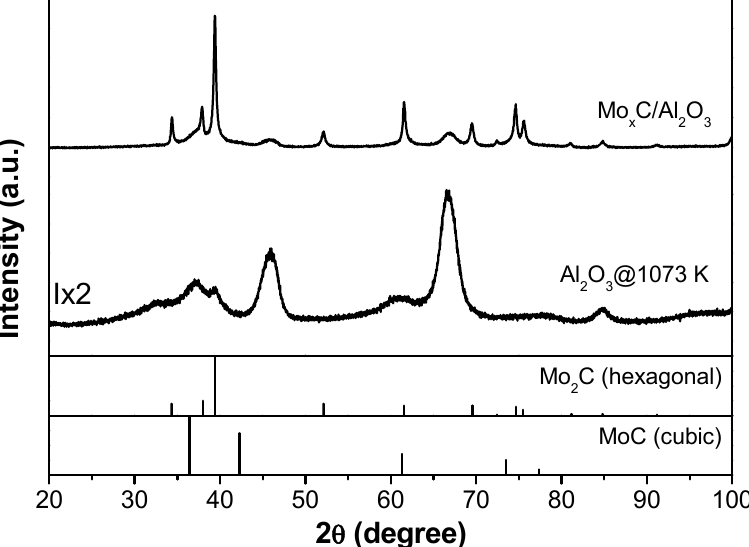
Figure 1. XRD patterns of Mo x C/Al 2 O 3 catalyst and the Al 2 O 3 support after thermal treatment at 1073 K.